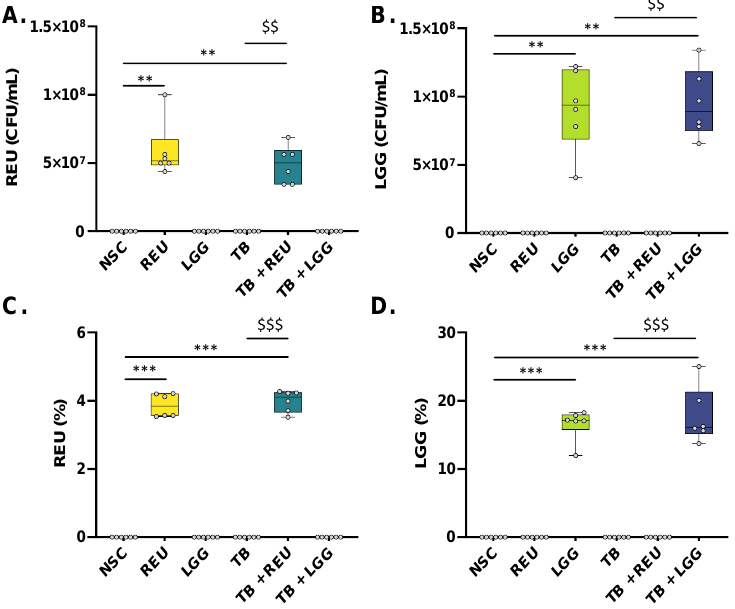
Figure 2. REU and LGG were exclusively detected in study arms where they were dosed, while remaining viable along the entire duration of the 48 h ex vivo experiment . Levels of REU ( A , C ) or LGG ( B , D ), after 48 h of incubation in the presence of fecal microbiota of 6 human adults using the ex vivo SIFR ® technology, as detected via culture-dependent selective enumeration (CFU/mL; A , B ) or culture-independent shallow-shotgun sequencing (%; C , D ). Statistical differences compared to the NSC are indicated with * (0.01 < p adjusted < 0.05), ** (0.001 < p adjusted < 0.01) or *** ( p adjusted < 0.001), while differences between TB + REU/TB + LGG and TB are indicated with $/$$/$$$. REU = Limosilactobacillus reuteri ; LGG = Lacticaseibacillus rhamnosus.